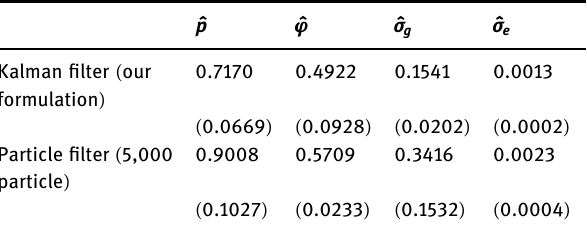
Table 1: Estimates of structural parameters using the particle fi lter and the Kalman fi lter with the proposed